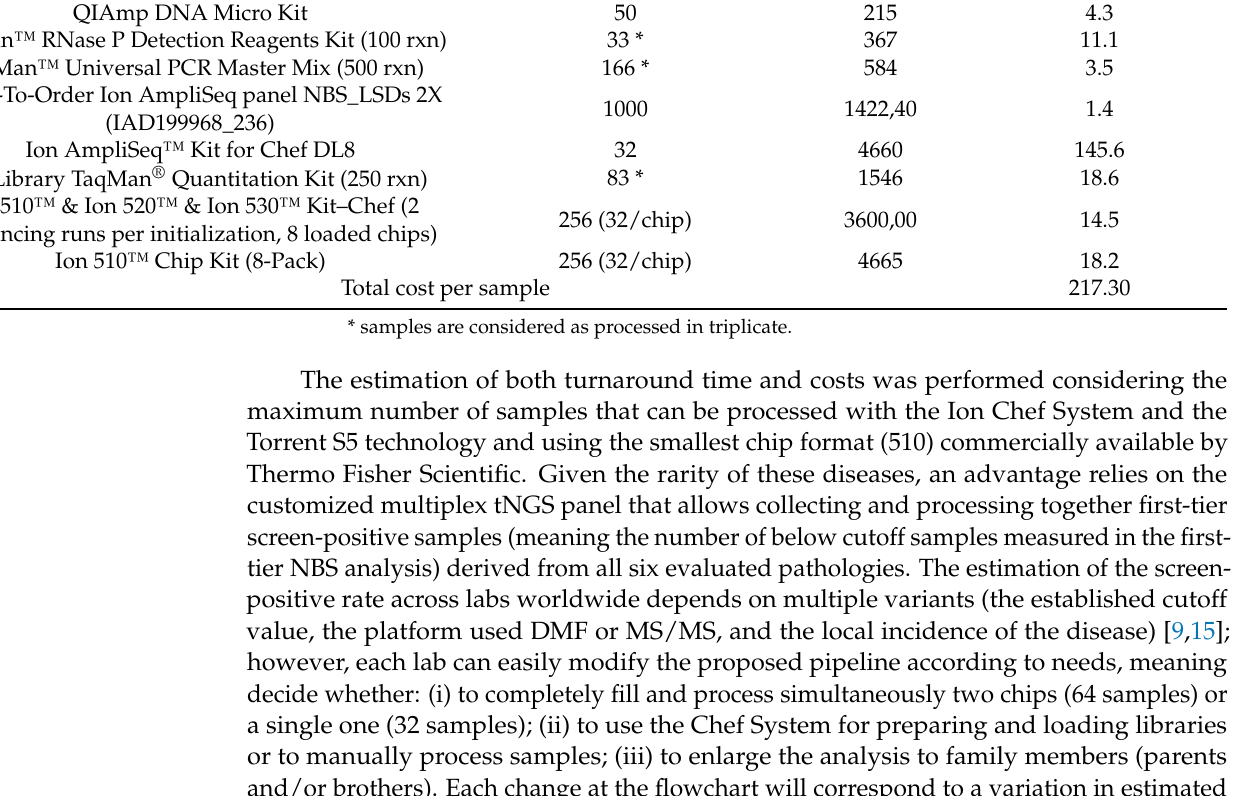
Table 2. Cost per sample (update June 2021) of consumables for semi-automatic sequencing with NBS_LSDs